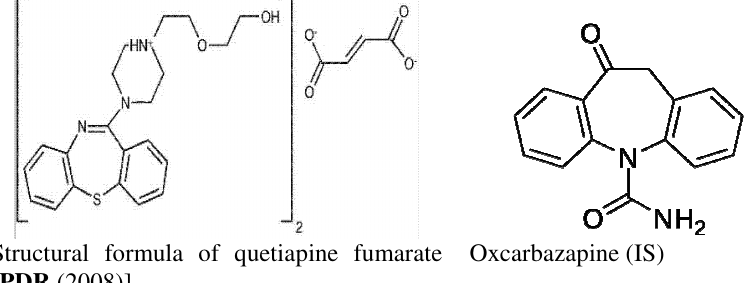
Figure 1. Chemical structures of QUE and